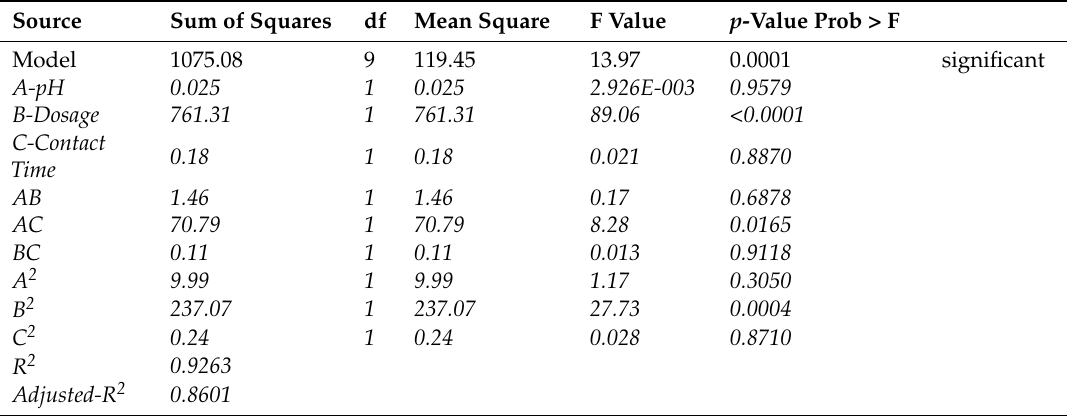
Table 5. Analysis of variance for the response surface of the quadratic